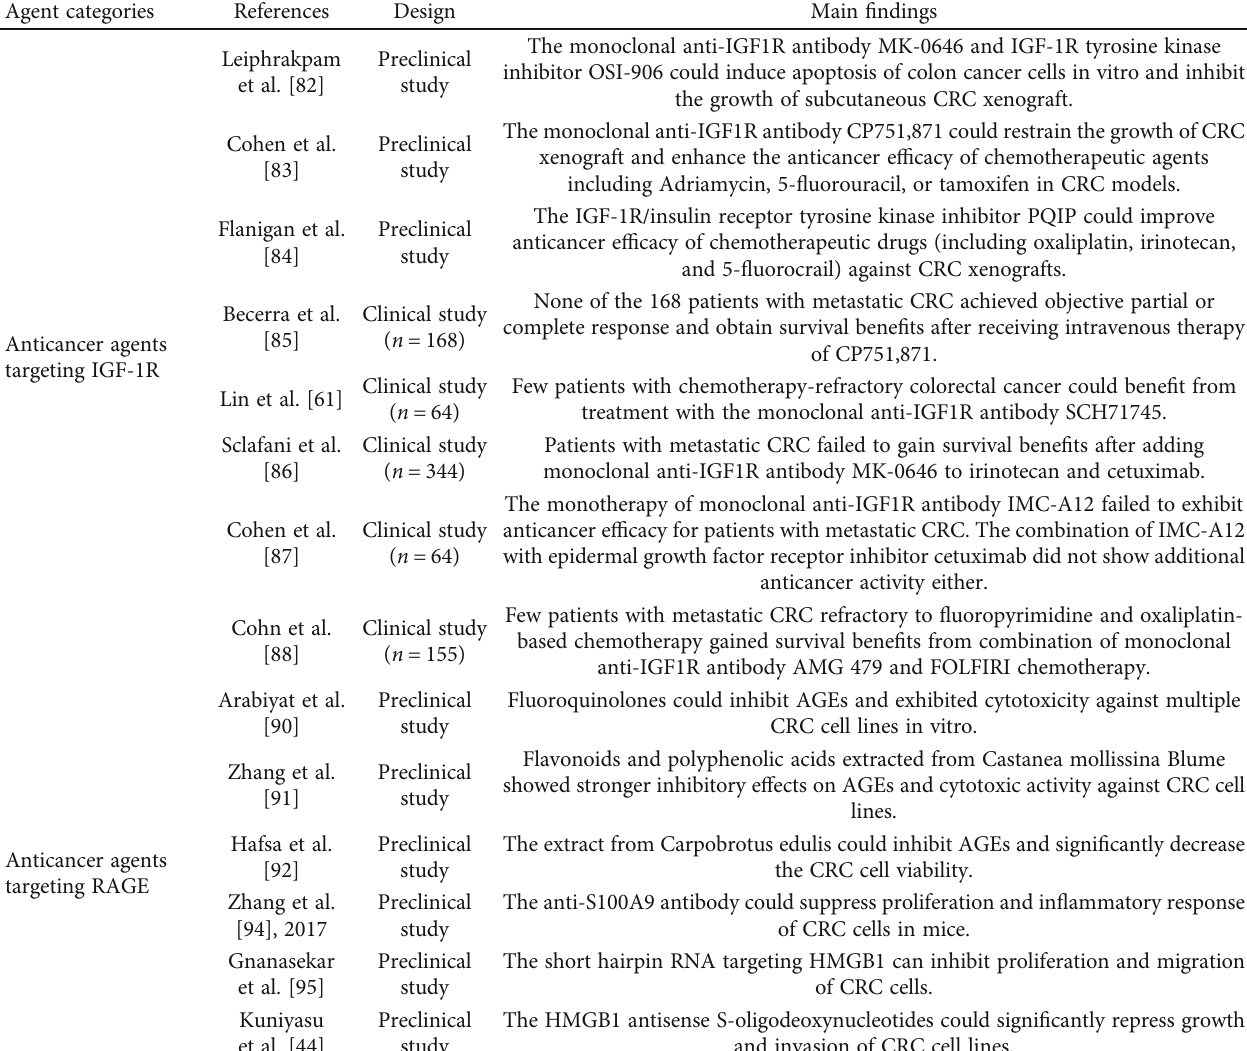
Table 2: Summary of representative anticancer agents targeting IGF-1R and RAGE against